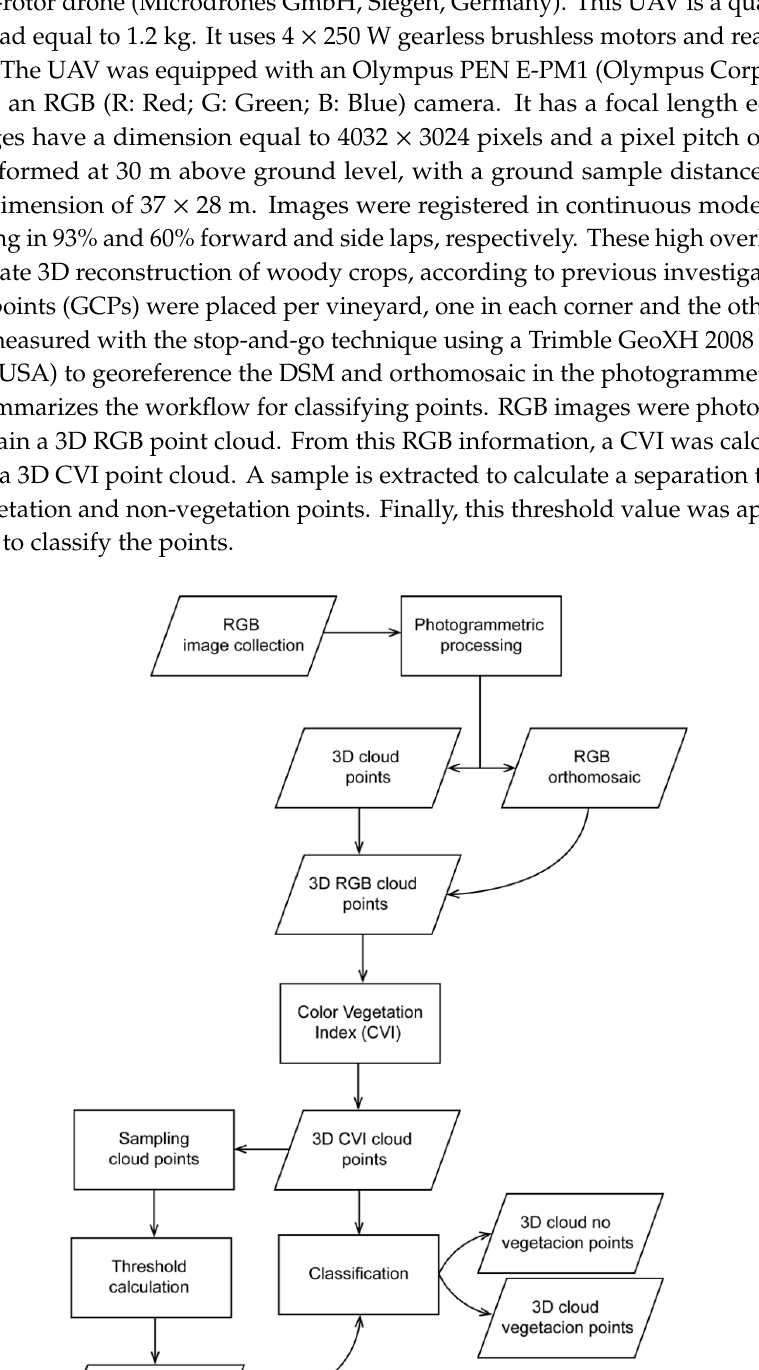
Figure 1. Study area: ( a ) general context and ( b ) locations of parcels.